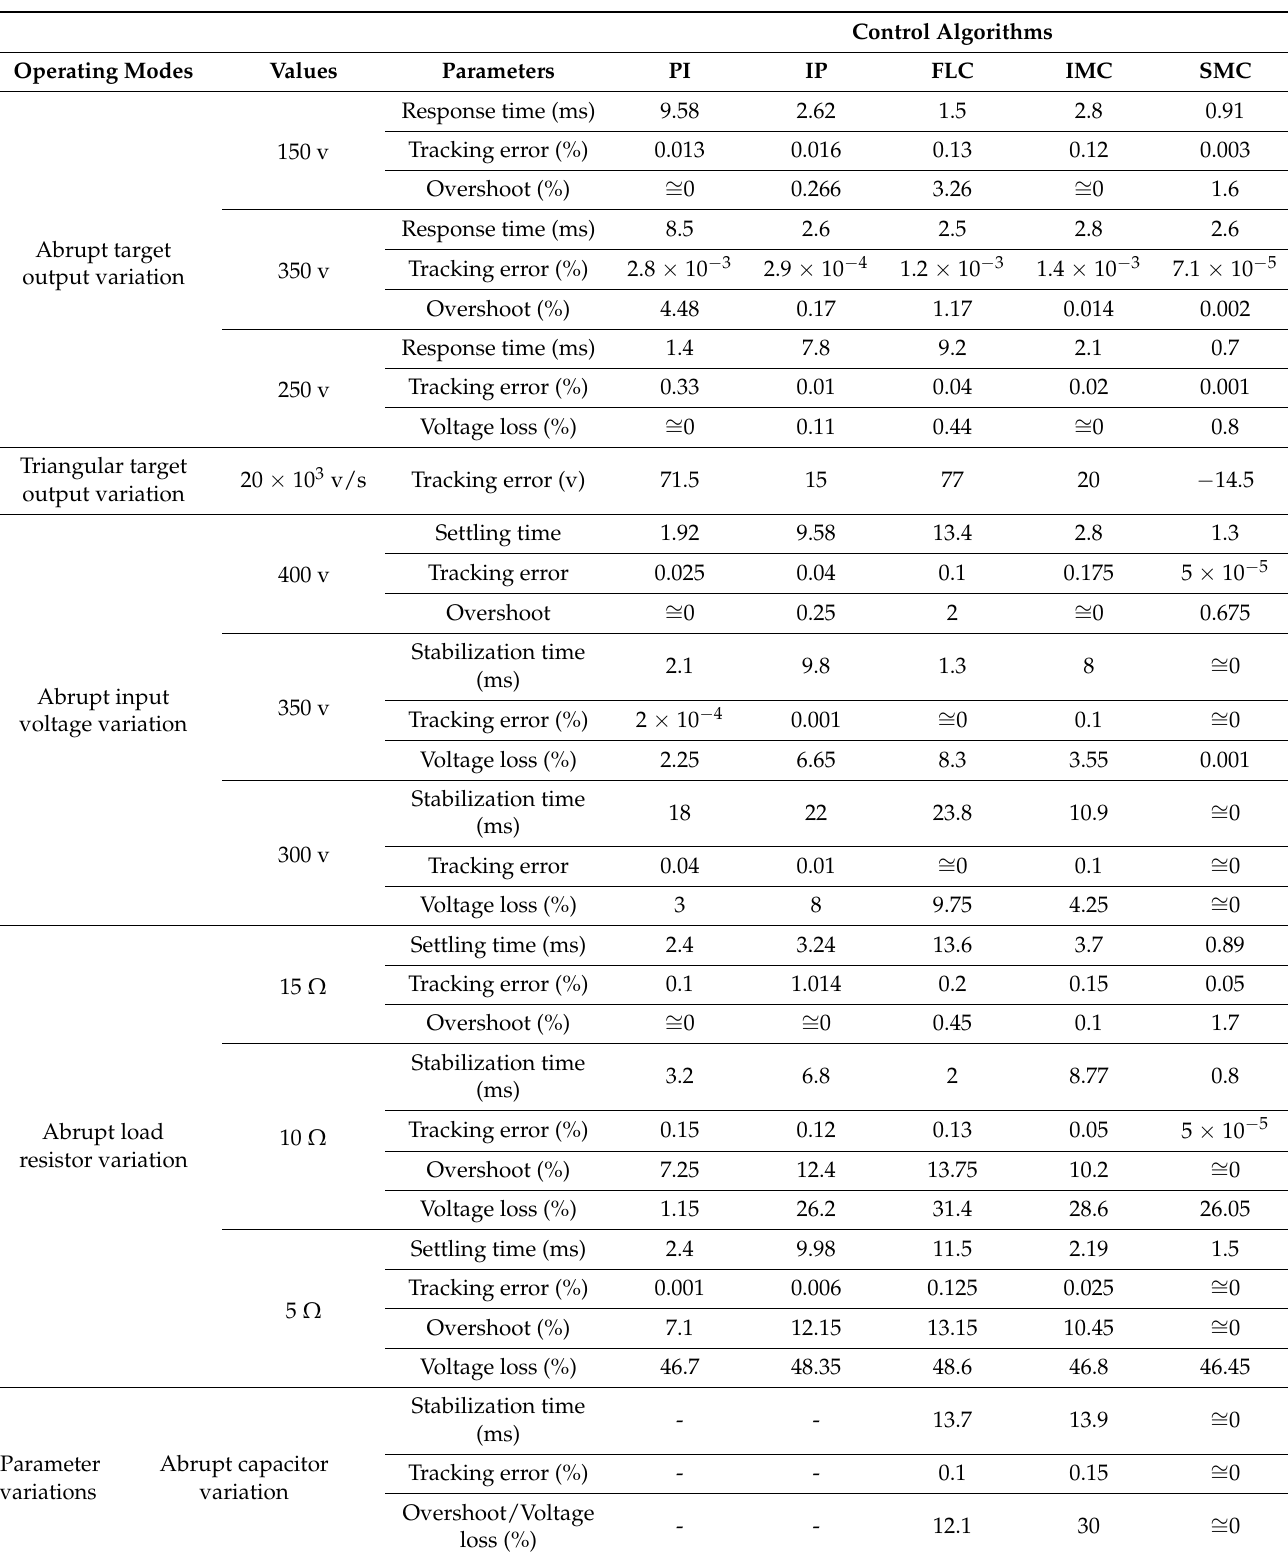
Table 3. Comparative study between the five algorithms.